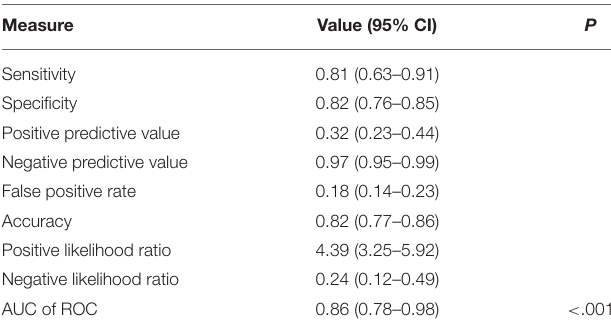
TABLE 2 | Maximum Z score ≥ 2.0 on baseline echocardiography as a predictor of late coronary artery aneurysms at 11 to 60 days of